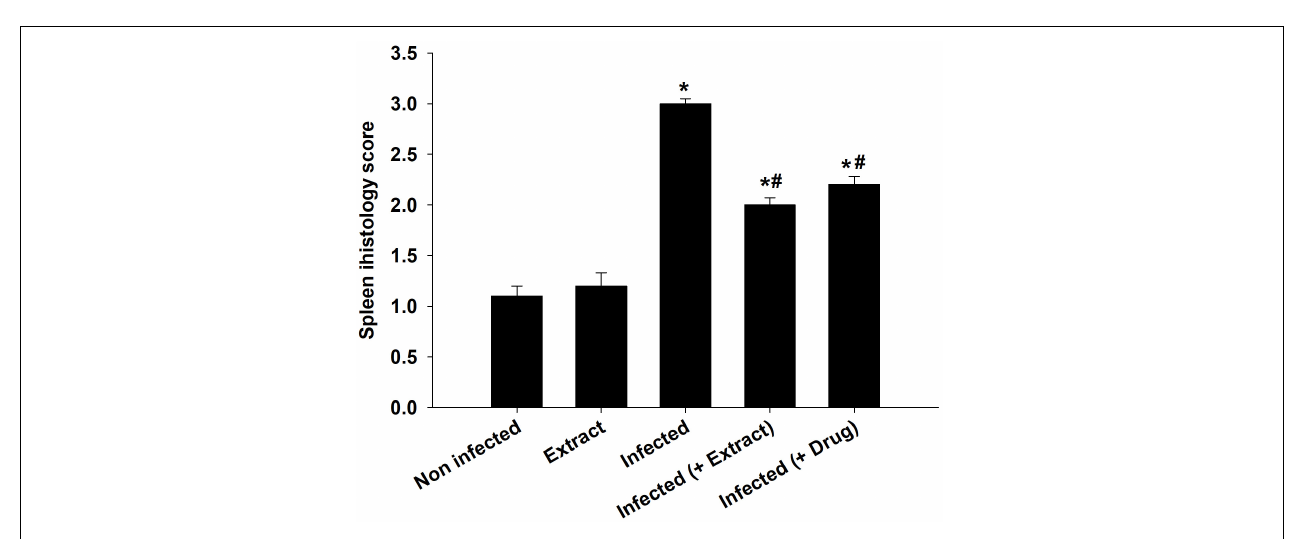
FIGURE 10 | Spleen histology score of mice. *, significance against control group at p ≤ 0.01. # , significance against infected group at p ≤ 0.01.